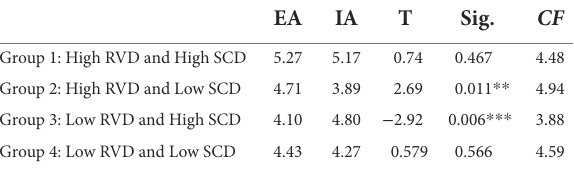
TABLE 2 Comparison within groups by paired samples